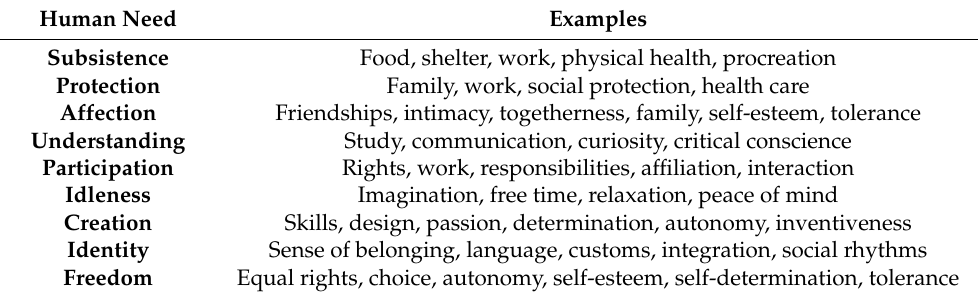
Table 2. Matrix of Needs and Satisfiers (based on Max-Neef 1991, pp. 32–33). Human Need